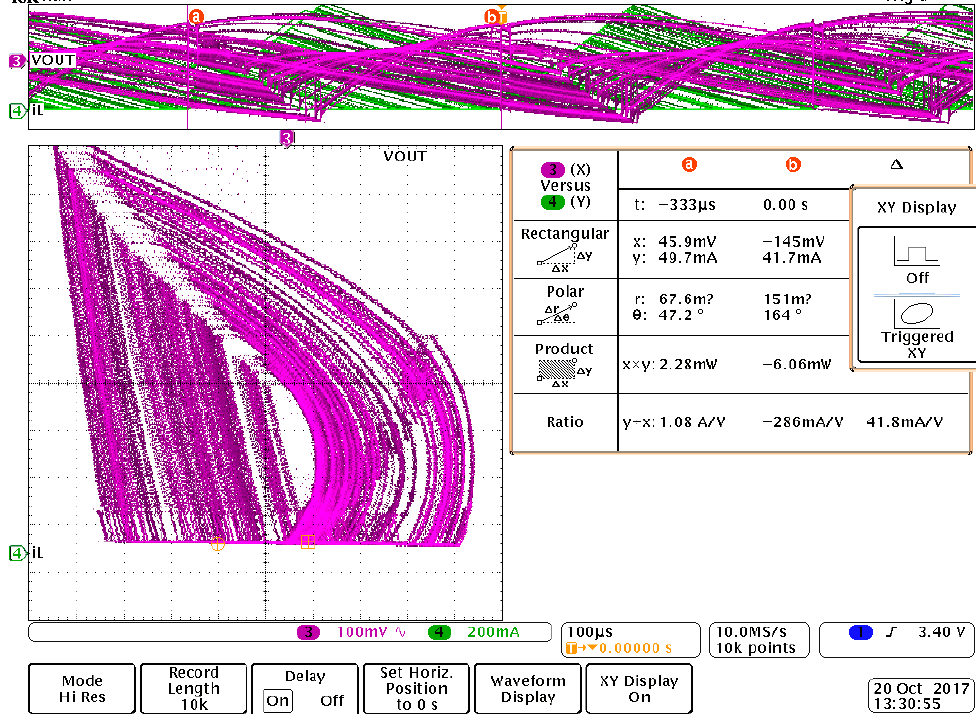
Figure 15. Chaotic operation of the converter corresponding to k = 1.50.